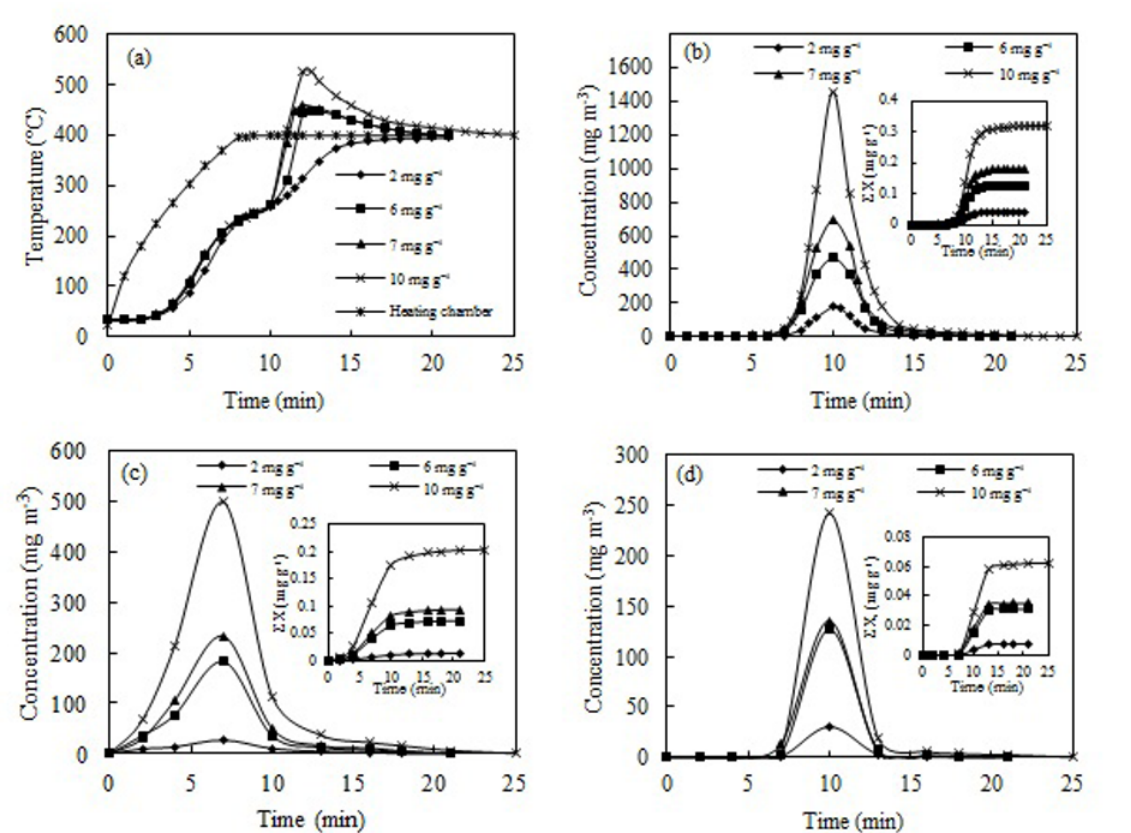
Figure 2. Temperature swing oxidation of toluene at different adsorbent-catalyst saturation levels: (a) temperature profiles of reactor and heating chamber; (b) evolution of CO; (c) thermal runaway of toluene; (d) evolution of benzene; insets - integral amounts ( Σ X) of desorbed/ formed